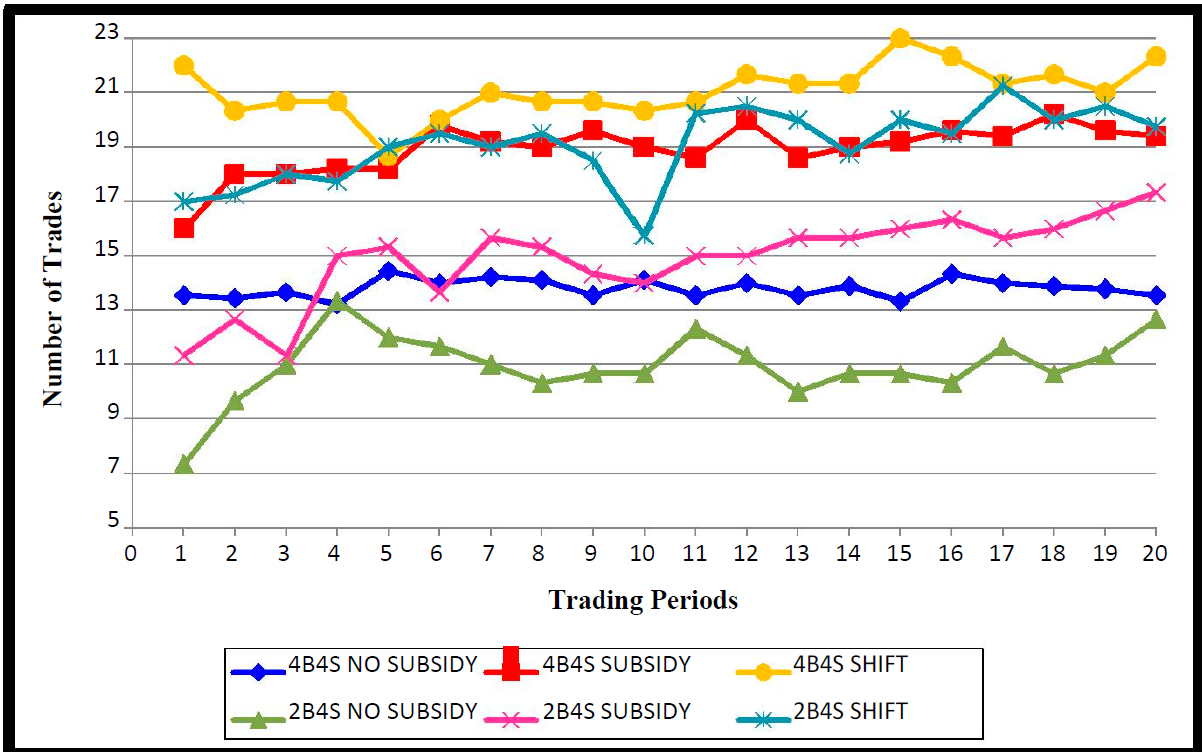
Figure 3. Average quantities traded per trading period by treatment.